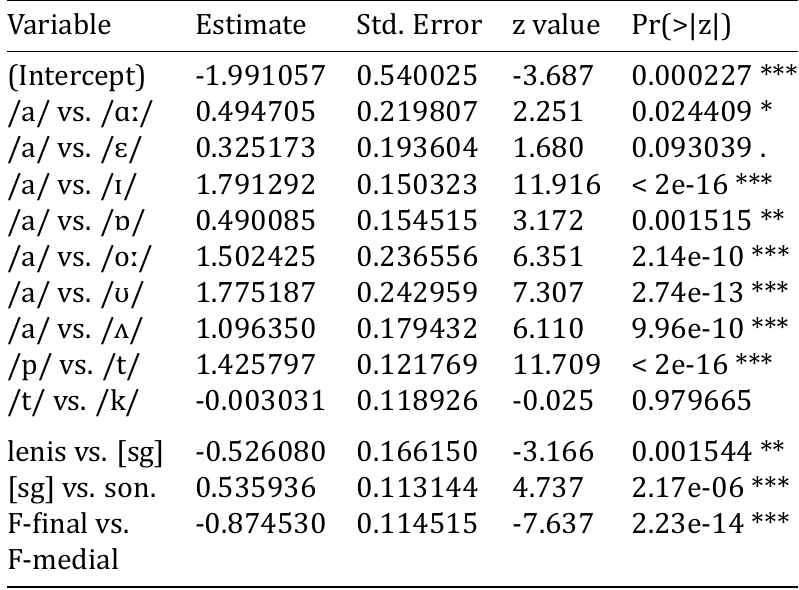
Table 2: Statistical results for the frequency of occurrence of breathiness